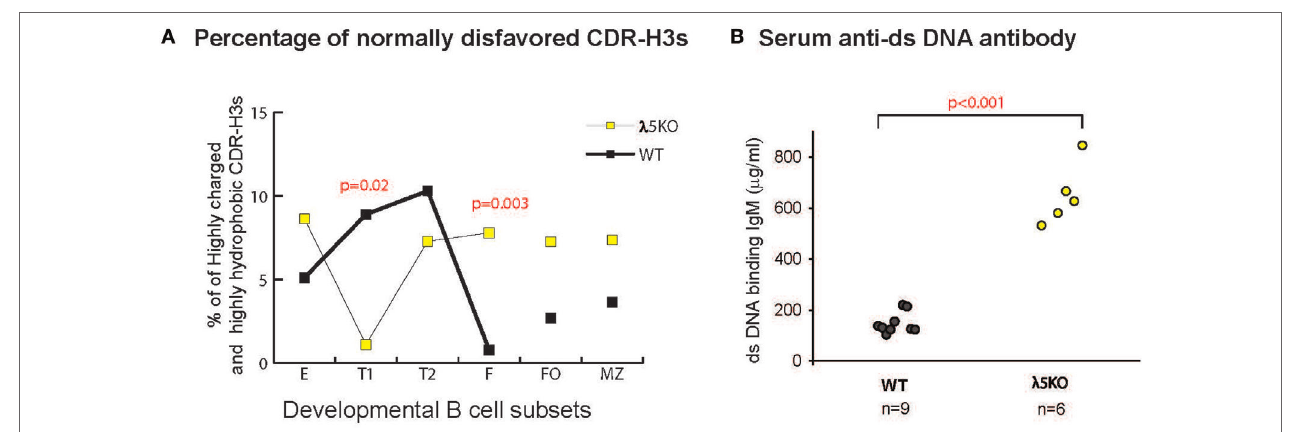
FigUre 7 | Prevalence of disfavored highly hydrophobic or highly charged CDR-H3s and dsDNA-binding IgM antibodies in λ 5KO versus wild-type (WT). (a) Comparison of the percentage of normally disfavored highly hydrophobic or charged CDR-H3 sequences obtained from λ 5KO versus WT in selected B cell subsets. A modified Kyte-Doolittle scale was used to assess hydrophobicity (30). Highly hydrophobic CDR-H3 sequences were identified as having an average hydrophobicity of greater than 0.6 on the scale, while highly charged are less than − 0.7. The p -values for differences that achieved statistical significance ( p ≤ 0.05) are shown. (B) Serum levels of dsDNA-binding IgM at 8 weeks of age in λ 5KO versus WT mice. Data represent analysis of 6 and 9 mice per group, respectively. The concentration of dsDNA-binding IgM was measured in microgram per milliliter. Student’s t -test was used for statistical analysis.